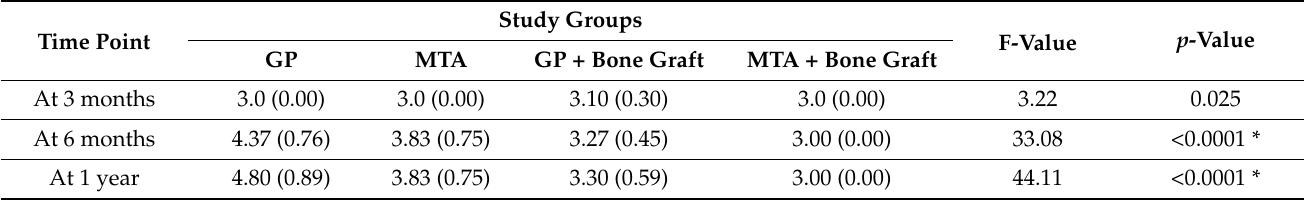
Table 4. Comparison of mean PD values among the 4 study groups at each of the 4 time points of follow up visits. Study Time Point